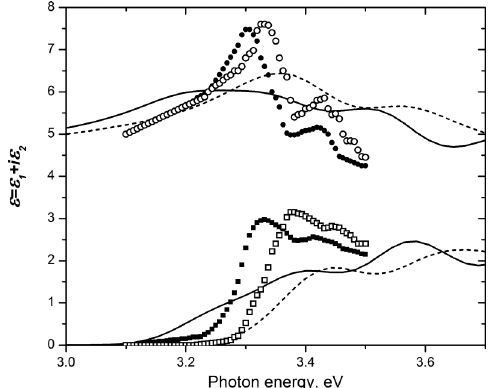
FIG. 7. Real (top of figure) and imaginary (bottom of figure) parts of the dielectric function spectra of w-ZnO bulk crystal calculated (lines) and measured (symbols) for ordinary (solid line, filled symbols) and extraordinary light (dashed line, opened symbols). Experimental data were obtained by generalized ellipsometry in Ref.